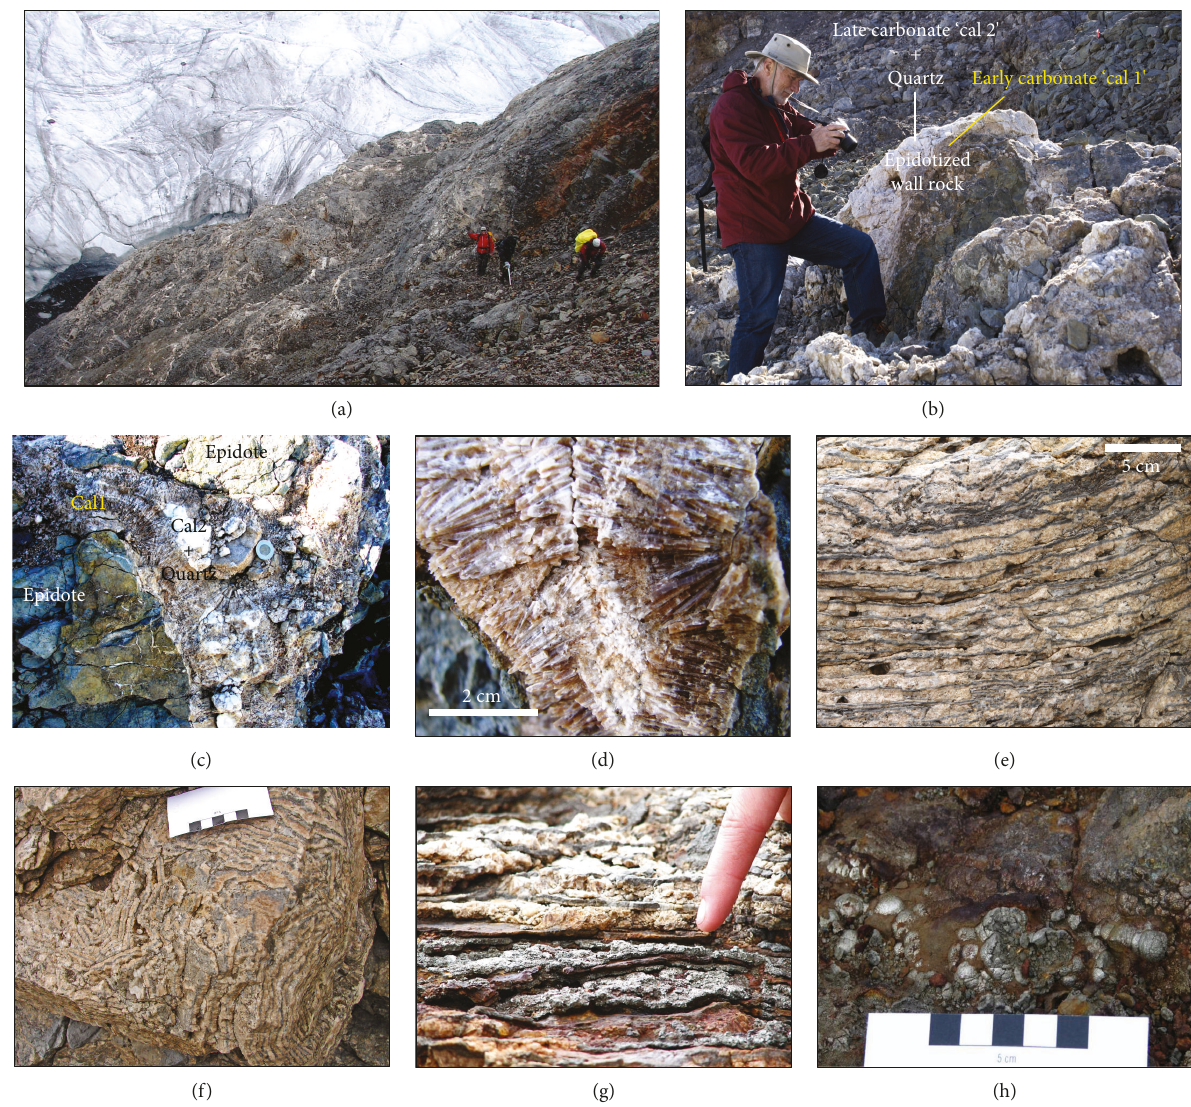
Figure 7: Outcrop-scale features of the WGVA site. (a) Partial overview of the site showing metal gossan (upper left) and hydrothermal veining in wallrock. (b) Outcrop within the exposure in (a) containing zoned calcite-quartz vein hosted in partial epidotized wallrock showing the relative size of vein structures (M. Zentilli for scale). (c) Individual vein showing early brown carbonate ( “ cal1 ” ) crystals symmetrically lining wallrock contacts, with a vuggy in fi lling white (sparry) calcite ( “ cal2 ” ) and quartz. Epidotized wallrock containing minor secondary vein splays occurs in the vein selvage. (d) Enlarged view of vein showing early brown carbonate crystals radiating from vein margins symmetrically towards the vein centre containing euhedral terminations and open space in this example. (e) “ Zebra ” texture showing alternating layers of carbonate- and sul fi de-rich hydrothermal mineralization (white-tan) with wall-rock septae (grey). (f) Contorted “ zebra ” texture indicating post-crystallization deformation. (g) Enlarged view of sul fi de-rich host rock layers separated by hydrothermal carbonate. (h) Botryoidal masses of